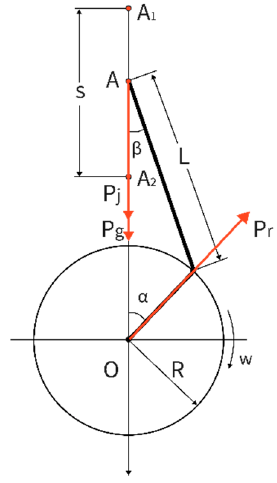
Figure 18. The distribution of